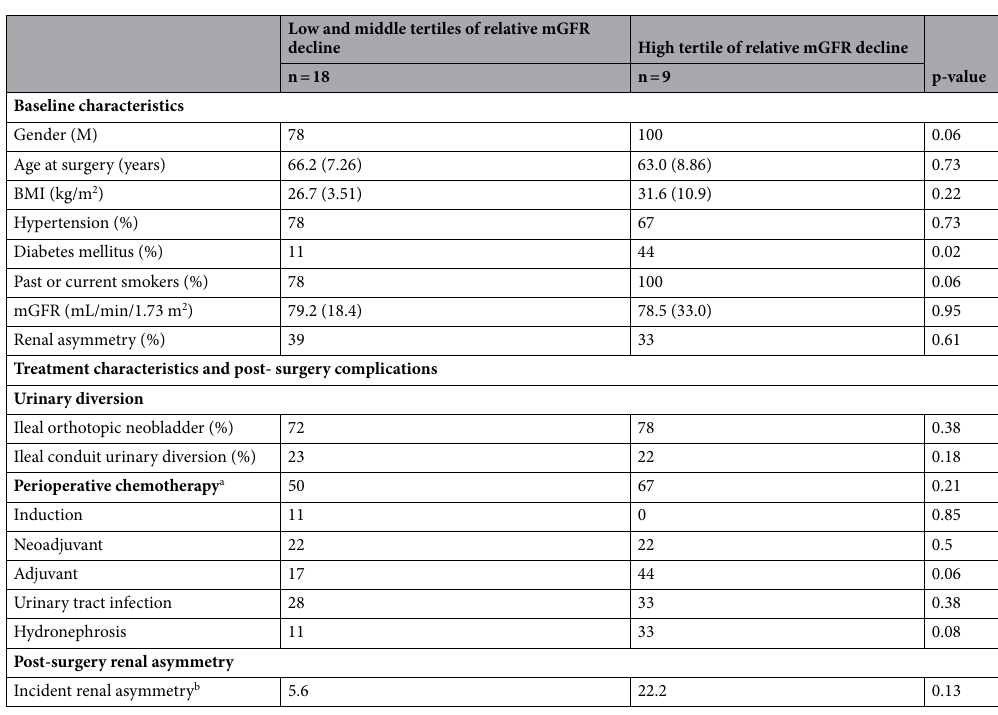
Table 2. Comparison of patients’ characteristics in the highest tertile of relative mGFR decline versus the two lower tertiles. Results are shown as percentage for qualitative data or mean (standard deviation) for quantitative data. M male, BMI body mass index, mGFR measured glomerular filtration rate. a All chemotherapy treatments included platinum salts. b Incident renal asymmetry was defined as the occurrence of a significant renal asymmetry after surgery (split renal function superior or equal to 45/55) due to a change in the split renal function > 5%.